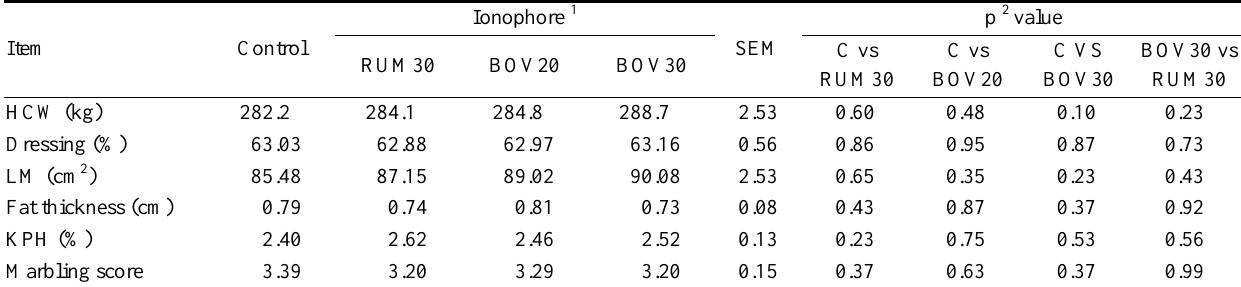
Table 4. Treatments effects on carcass characteristics in feedlot